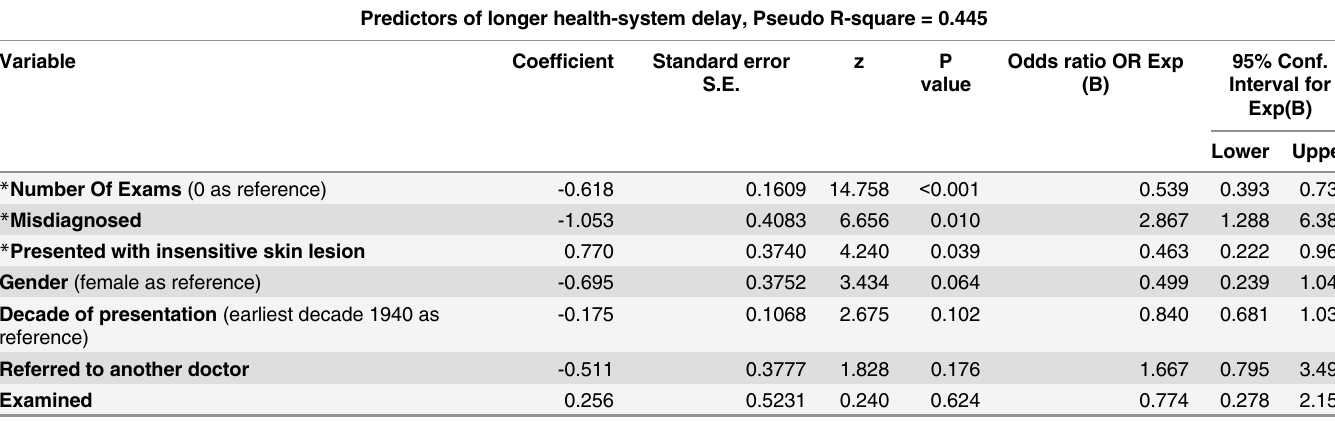
Table 5. Ordinal and logistic regression models for predictors of longer diagnosis time and delayed diagnosis respectively. Predictors of longer health-system delay, Pseudo R-square =